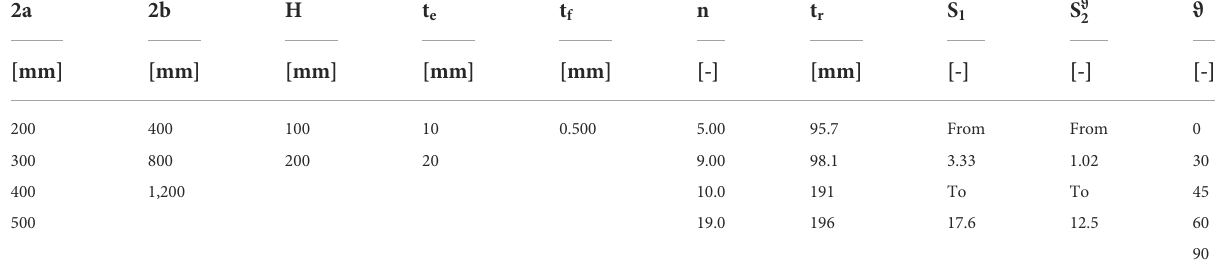
TABLE 1 Variable geometric parameters in the set of